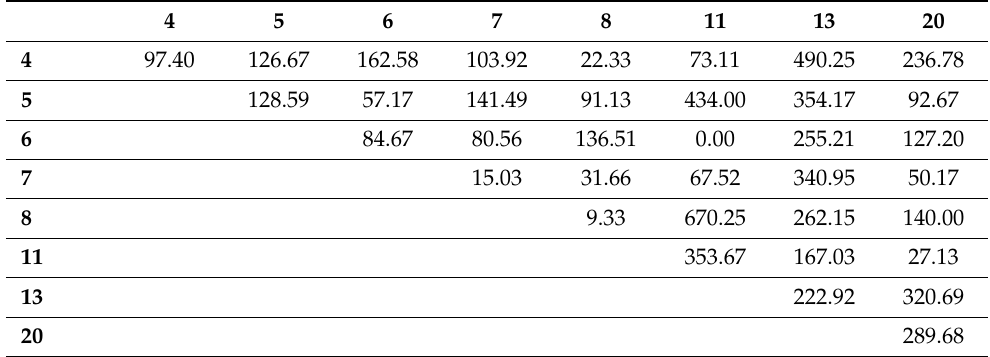
Table 4. Market yield (g/plot) of parents (on diagonal) and experimental hybrids (above diagonal) for Set 1. See Table 1 for parental codes. Least square differences between means = 209.4, p < 0.05.